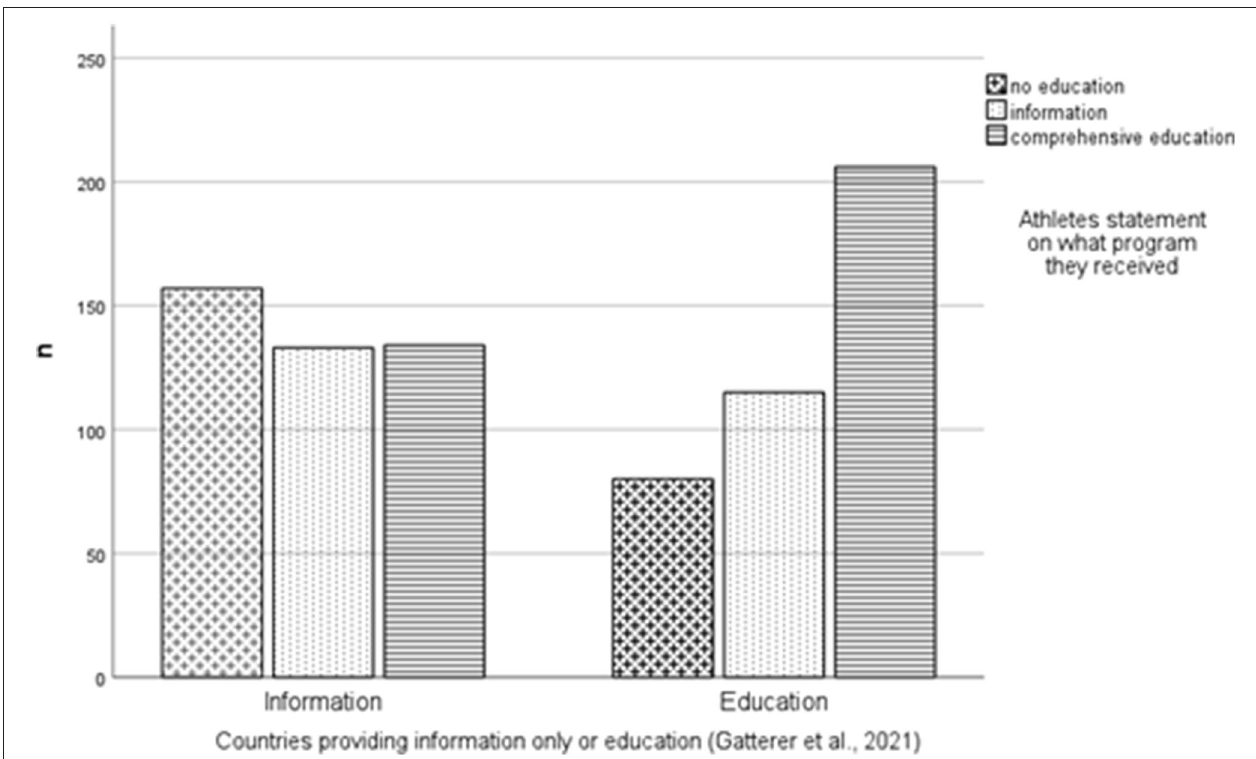
FIGURE 4 | Distribution of perceived education of athletes from countries providing either information or education. Chi square: 41.37, p < 0.001, Phi: